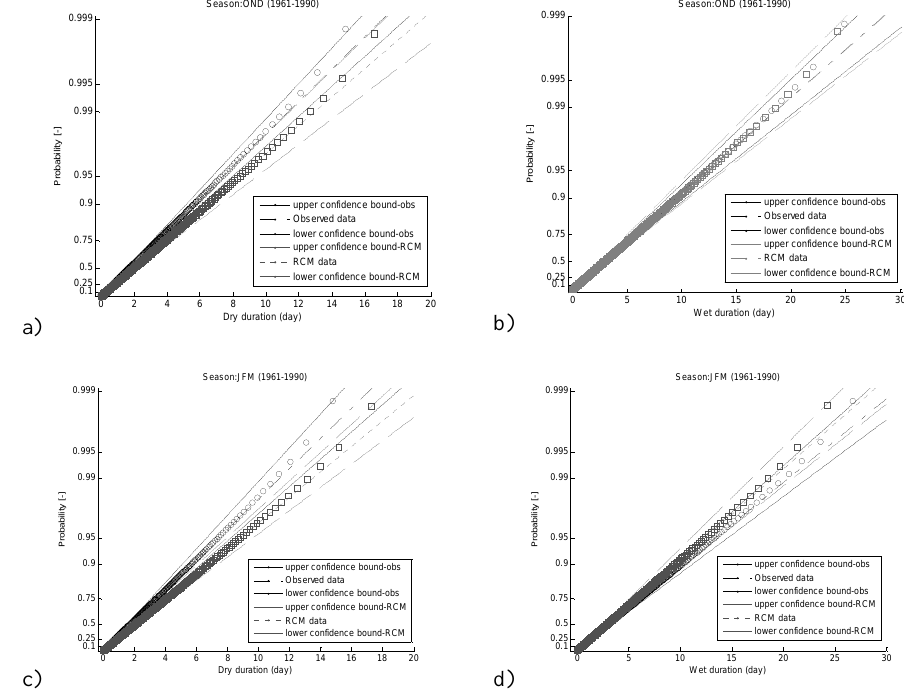
Fig. 4. Exponential probability plots for the wet and dry periods in autumn (OND) and in winter (JFM) computed from the reference observations (with circles) and the RCM (with squares), using data from a single grid-cell. Straight lines represent the corresponding theoretical distributions with their respective 95% confidence bands for autumn dry periods (a) , autumn wet periods (b) , winter dry periods (c) , and winter wet periods (d)